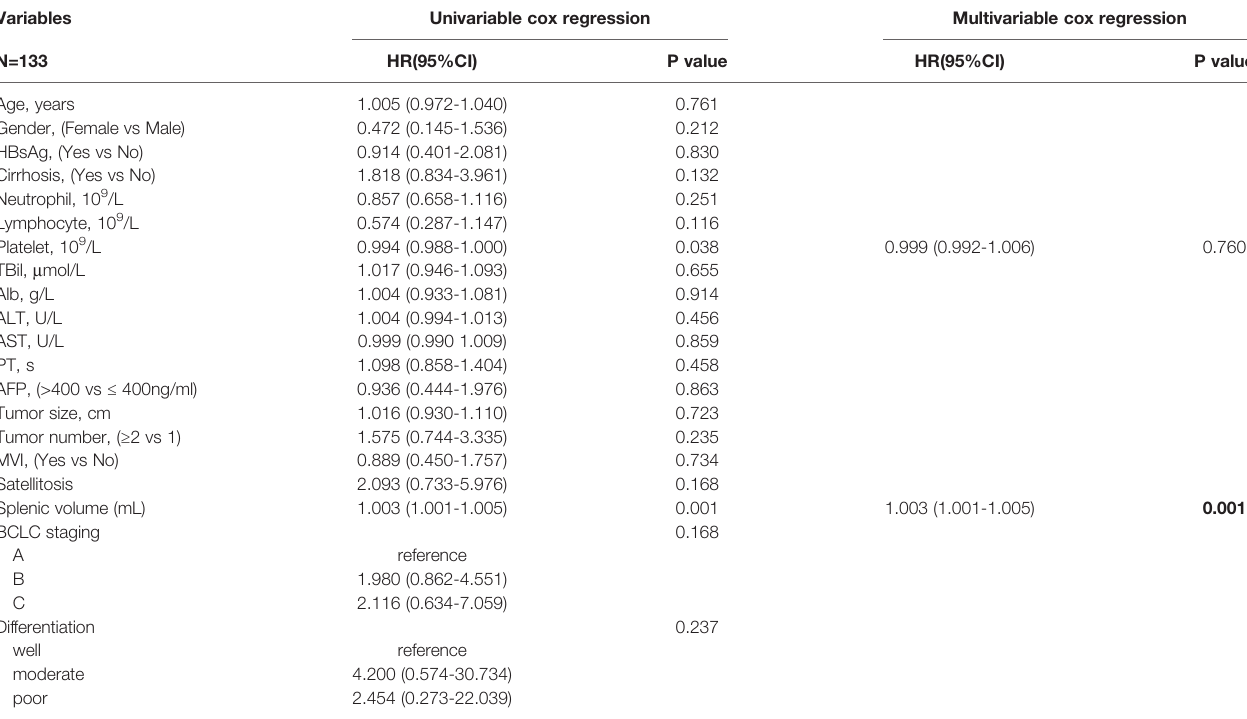
TABLE 3 | Univariable and multivariable analyses for independent variables associated with HCC late recurrence.